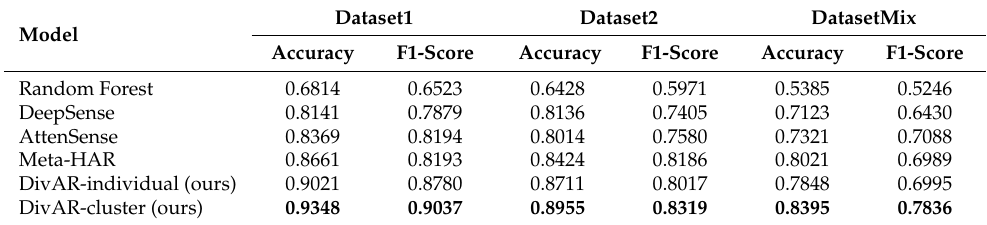
Table 4. Performance (Accuracy and F 1 score ) on generalizing within existing individuals of the baseline method and DivAR on three